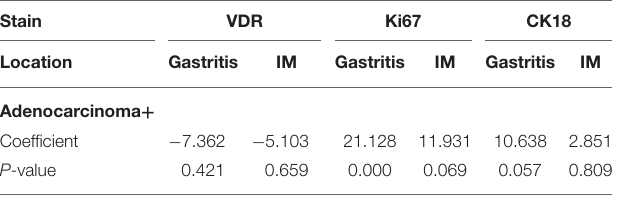
TABLE 3 | Scheffe post hoc analysis among different stains and